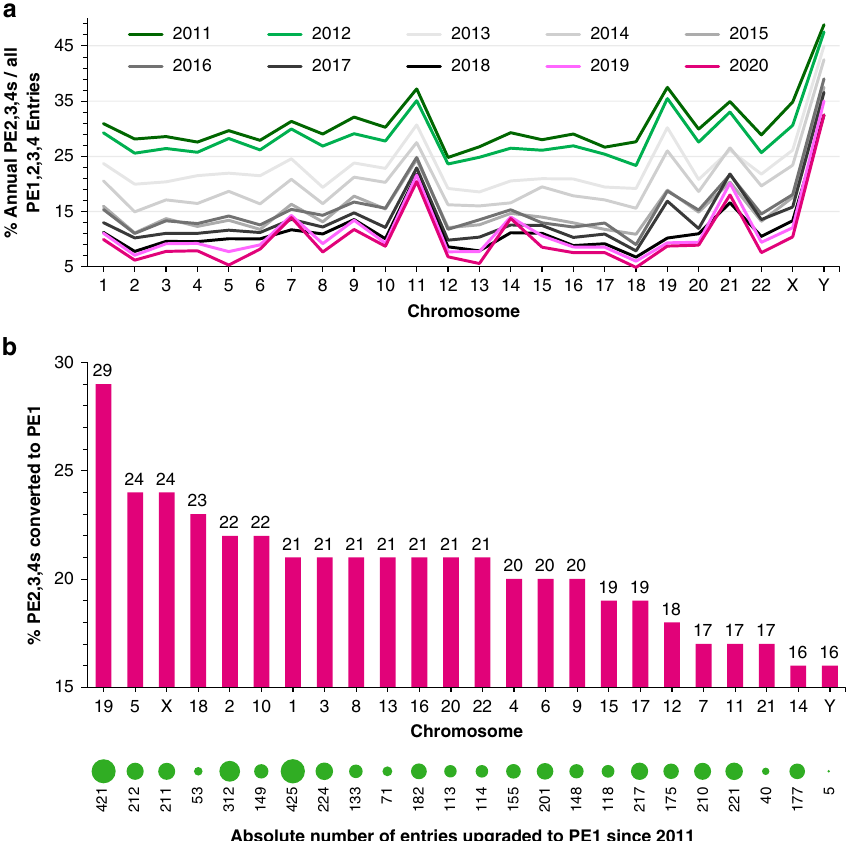
Fig. 4 Progress in reducing the fraction of missing proteins for all human chromosomes. a The percentage of missing proteins (PE2,3,4) relative to all protein-coding genes (PE1,2,3,4) plotted annually according to human Chrs 1 – 22, X and Y location from the fi rst neXtProt release (23-08-2011) to the latest HPP reference release (17-01-2020). b The relative percentage (magenta bars) and absolute number (green dots) of all neXtProt PE2,3,4 missing protein entries speci fi cally upgraded to PE1 since 2011 across Chrs 1 – 22, X and